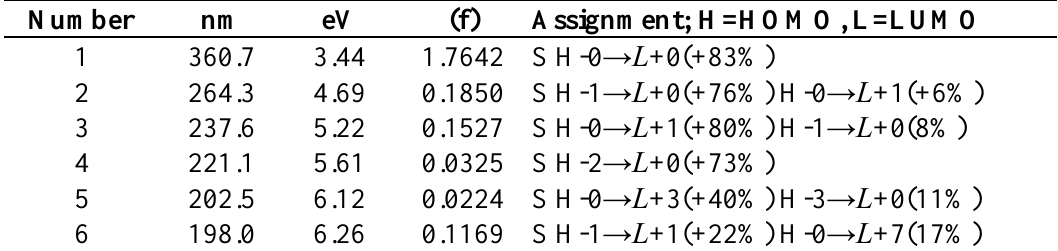
Table 8. Electronic transition states of retinoic acid (nm, eV, oscillator strengths (f), and transition assignments as calculated with TD-DFT and the M05-2X/6-31G(d,p) level of theory. Only the transition states with f > 0.02 are